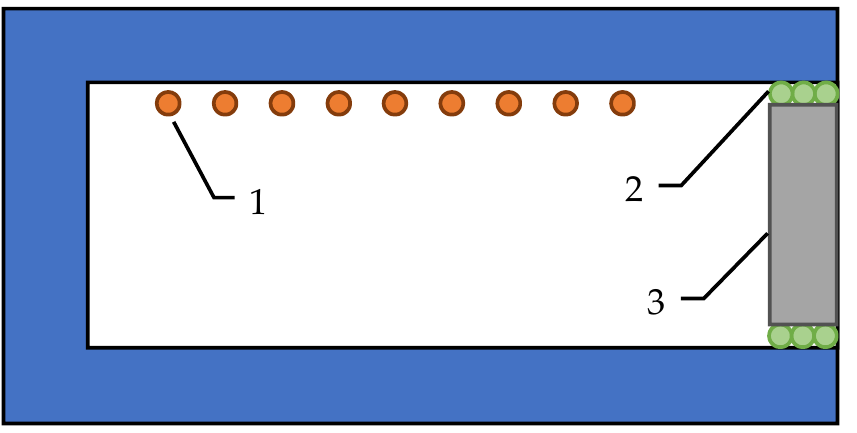
Figure 4. Scheme of the measuring system: (1) heating element, (2) high-temperature insulation material, (3) geopolymer sample in the form of plates with dimensions of 100 mm × 150 mm × 50 mm [33]. Changes in thermal radiation were examined on the outer surface of the sample (Figure 5) with the use of a FLIR thermal imaging camera with a field of view (FOV) ≥ 38 ◦ , thermal sensitivity < 70 mK, measured infrared wavelength range in the range of 7–14 µ m and pixel size < 15 µ m. The camera was set at a distance of 1.5 m from the furnace in which the sample was placed. Measurements were made in the center of the sample at a frequency of 60 s for the first hour, with the next reduction in the frequency of the measurement readings until temperature stabilization was achieved. The measurement was completed after three